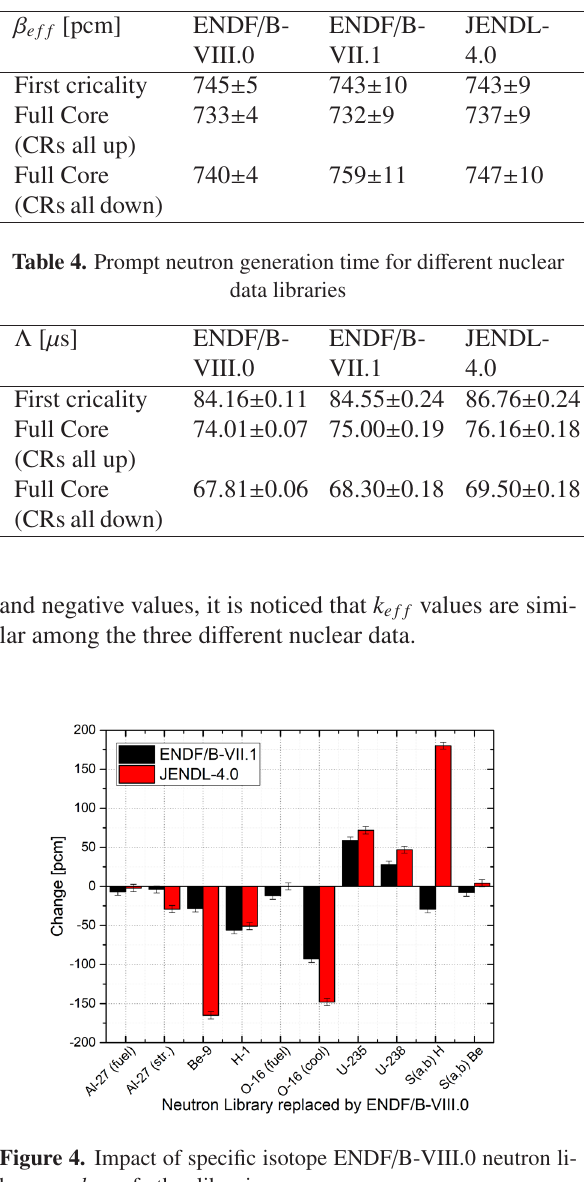
Figure 3. C / E of k ef f for di ff erent nuclear data libraries